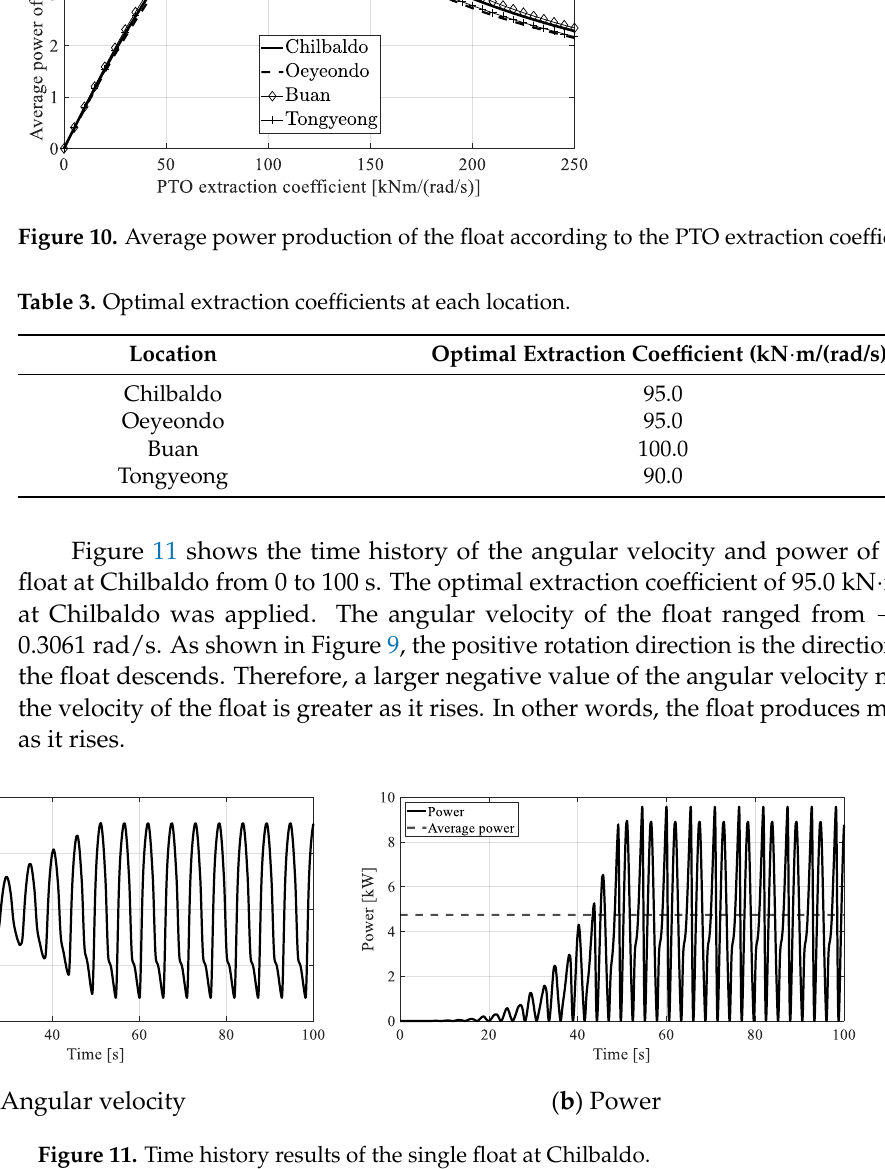
Figure 11. Time history results of the single float at Chilbaldo.